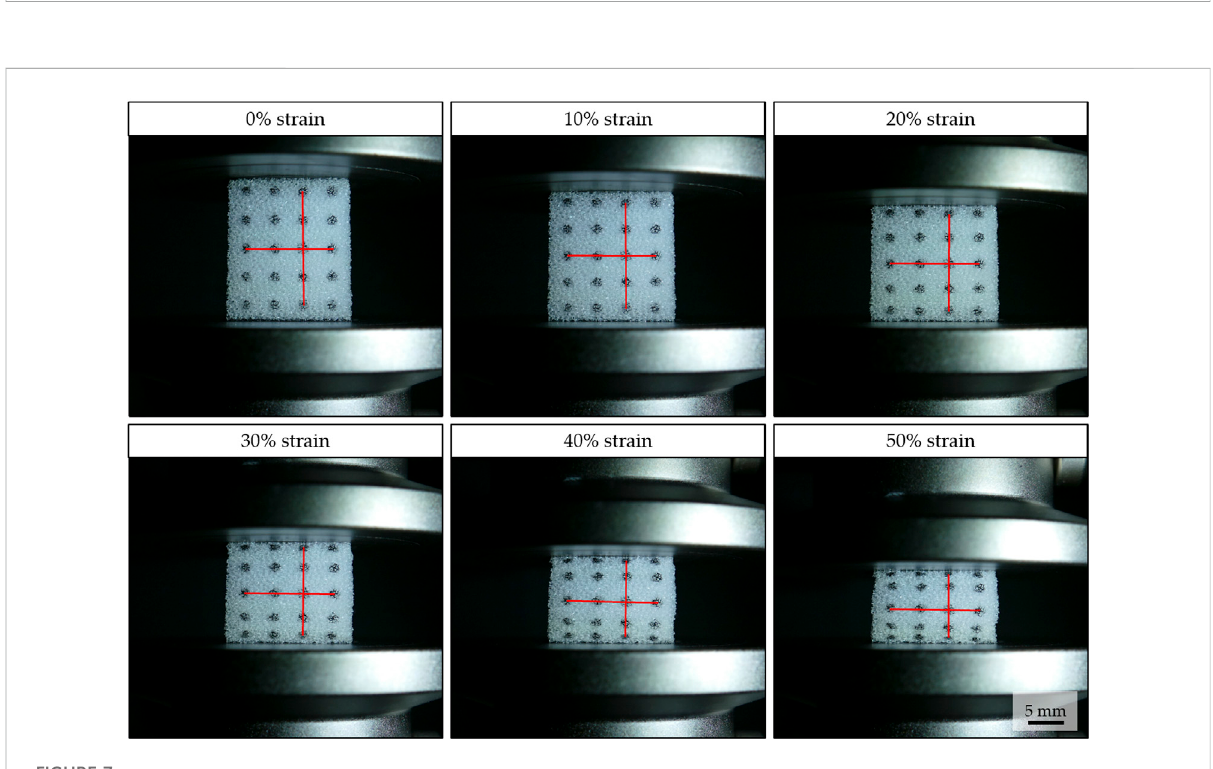
FIGURE 7 Characteristic deformation images of the PU foam (RG35/50) at increasing strain. Sample height at a strain level of 0% is 19.86 mm.